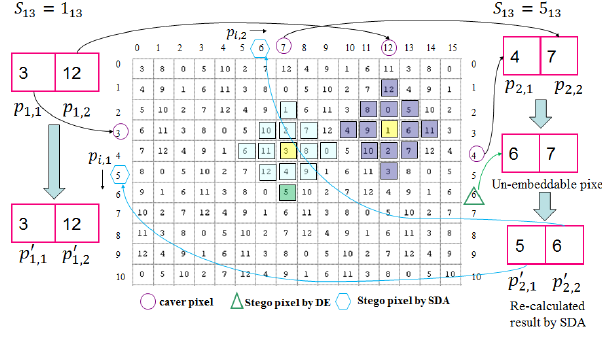
Figure 4. Illustration of proposed method